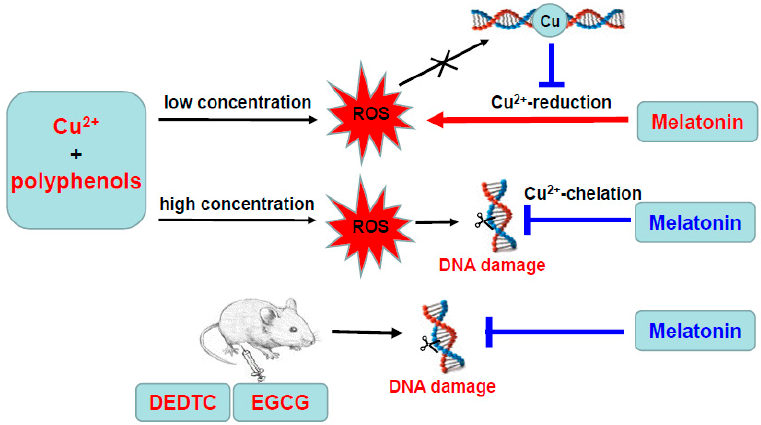
Figure 11. Summary diagram of the present study.